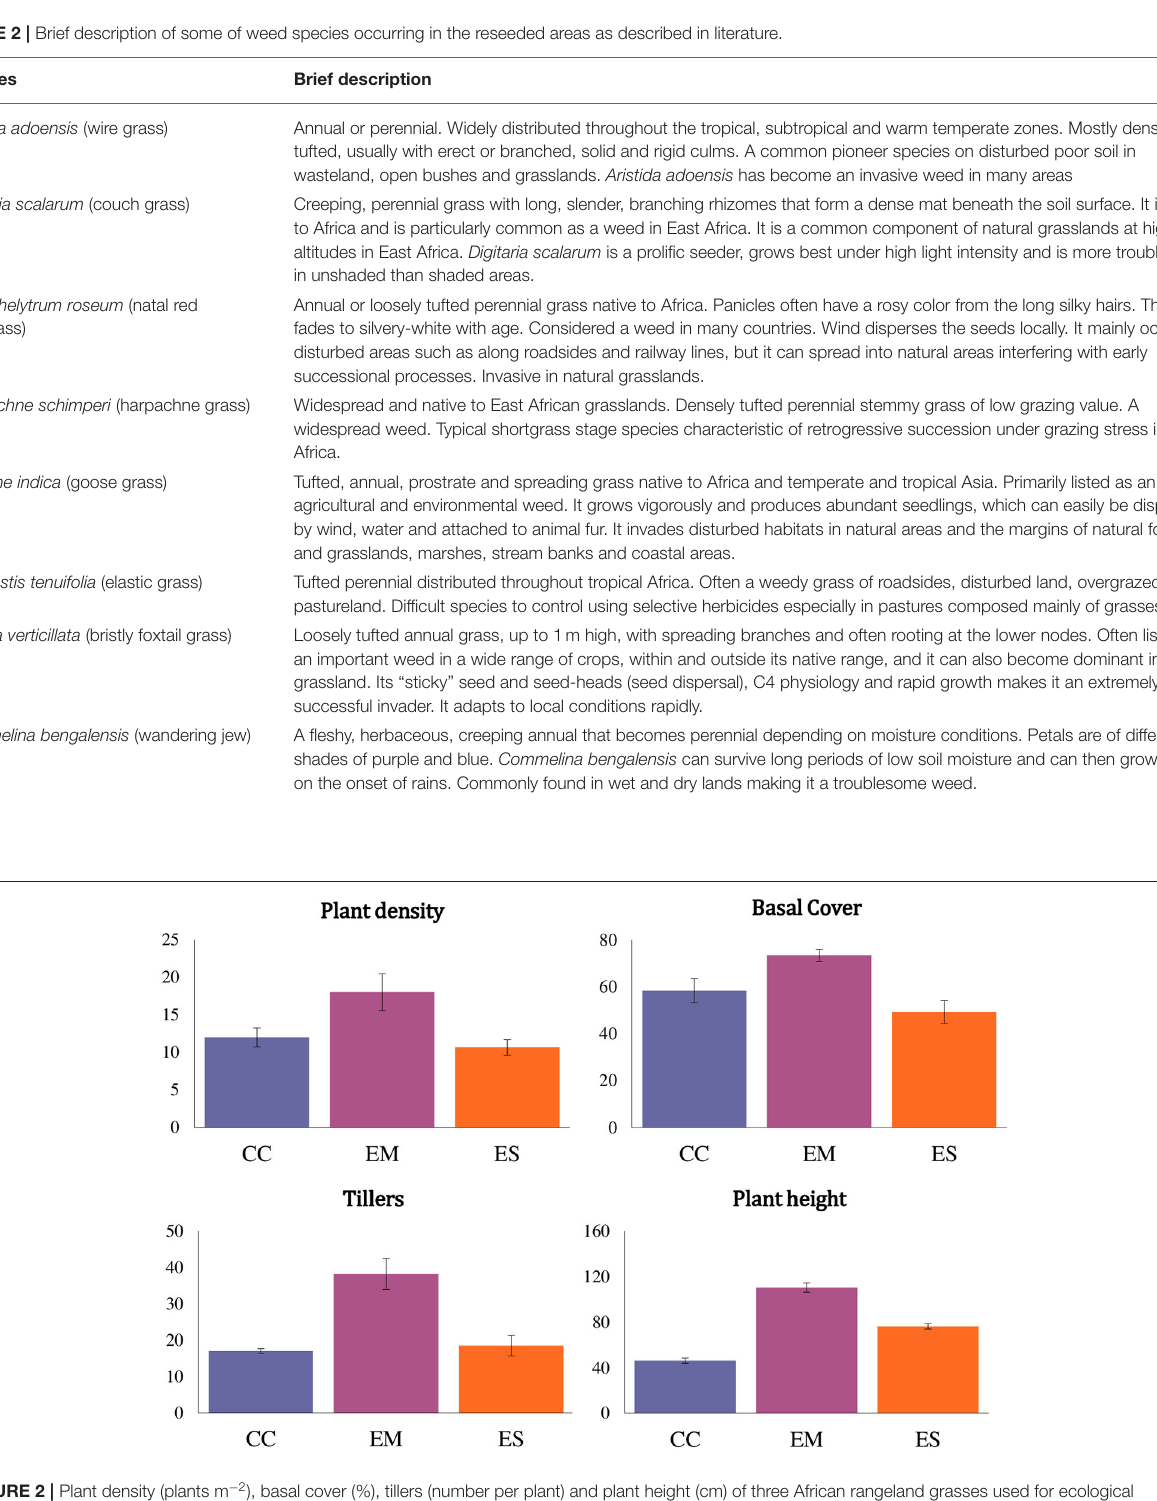
FIGURE 2 | Plant density (plants m − 2 ), basal cover (%), tillers (number per plant) and plant height (cm) of three African rangeland grasses used for ecological restoration 9 months after establishment. Where CC, Cenchrus ciliaris; EM, Enteropogon macrostachyus; ES, Eragrostis superba. Error bars represents standard error ( ± SE) of means ( n =